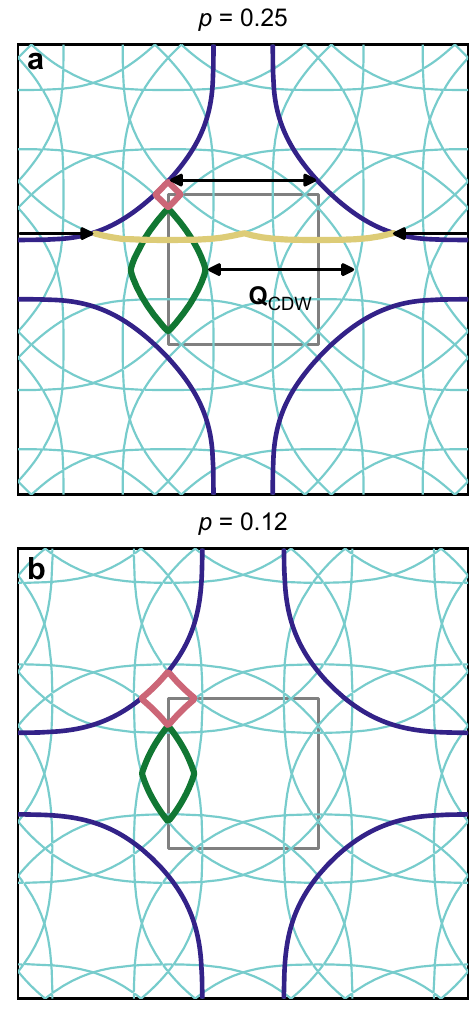
Fig. 6 Model of Fermi surface reconstruction in Tl2201. A commensurate Q = 2 π /3 has been used. a Shows the reconstruction for p = 0.25 and b for p = 0.12. The original unreconstructed FS is shown in dark blue. Arrows connect positions that are gapped in the reconstructed FS. The reconstructed electron pockets are coloured red, and the hole pockets green. The open FS sections are coloured sand for p = 0.25. The reduced Brillouin zone (BZ) appropriate to the commensurate order is shown by the small grey rectangle in the centre. The thin turquoise lines show all the contours of the reconstructed FS. For the p = 0.25 simulation, the hole pockets (2 per BZ) contain 0.054 holes and the electron pockets (1 per BZ) 0.003